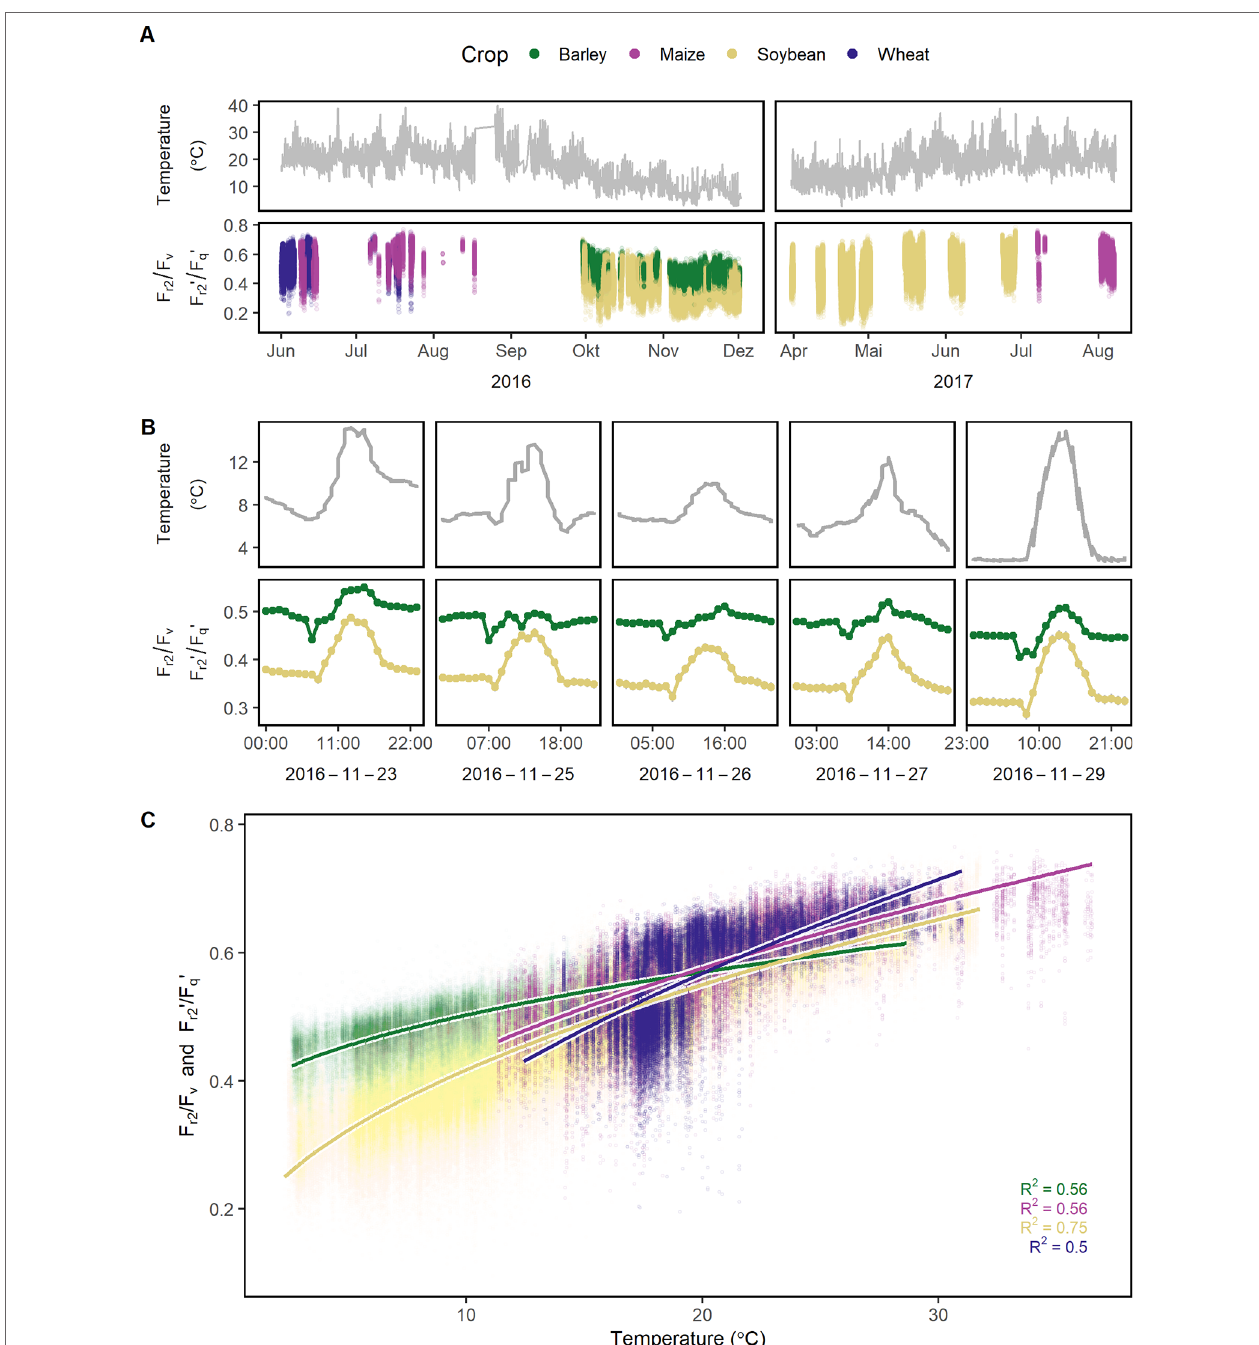
FIGURE 4 | Reoxidation efficiency 5 ms after primary quinone (Q A ) reduction (F r2 /F v in the dark and F r2 '/F q ' in the light) of barley, maize, soybean, and wheat genotypes was monitored under a fluctuating environment over two seasons in high time resolution. (A) Temperature fluctuation together with the dynamic F r2 /F v and F r2 '/F q ' of the four crop species is shown over the two growing seasons (n = 778,224, acquired from May 2016 to August 2017). (B) Temperature and F r2 /F v (respective F r2 '/F q ') are shown in a subset of diurnal measurements within 1 week to illustrate the strong interaction between the parameters. F r2 /F v and F r2 '/F q ' were grouped according to crop species to reveal the strong effect of the different species. Gray error bars show 95% confidence interval (n = 58 to 171 independent measurements averaged per crop species and hour, in total = 30,704). (C) F r2 /F v and F r2 '/F q ' were correlated to temperature and fitted to a linear model depending on temperature (temperature was square root transformed, all measurements were used, n = 33,902 to 604,857 measurements per crop species). Chlorophyll fluorescence data was acquired by an automated light-induced fluorescence transient (LIFT) device scanning over the crop canopy. Temperature was recorded every minute by three stations distributed in the unheated glasshouse and linked to LIFT measurements done in the same minute.